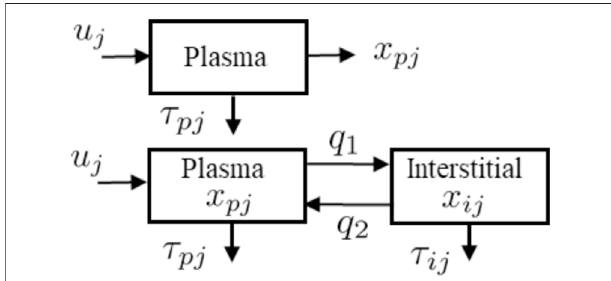
FIGURE 2 | Schematic representations for the single-compartment model (Top) used to describe plasma insulin and c-peptide, and two- compartment model (Bottom) used to describe both plasma and interstitial insulin and